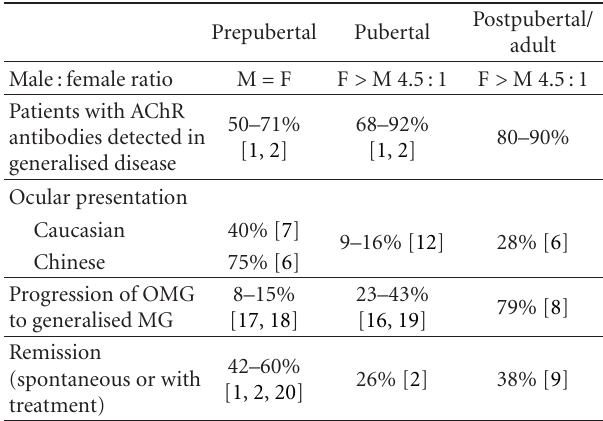
Table 1: Comparisons of prepubertal and postpubertal features of